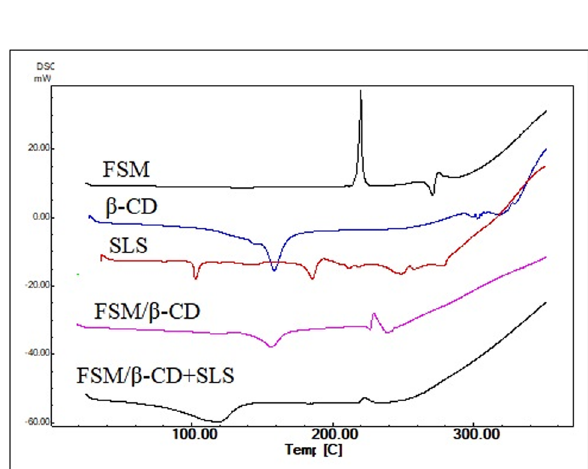
Figure 3: Comparative DSC spectra of complexes.